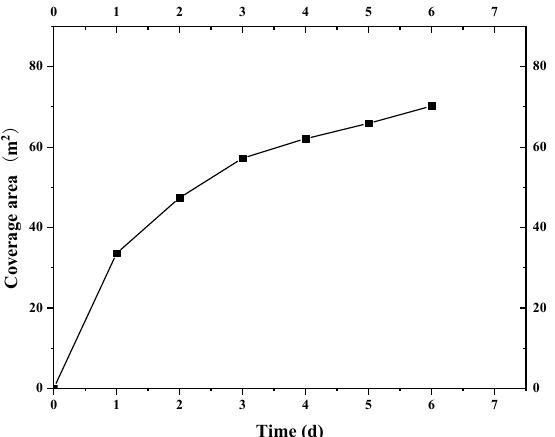
Figure 10. Variation curve of bacterial coverage area with time.